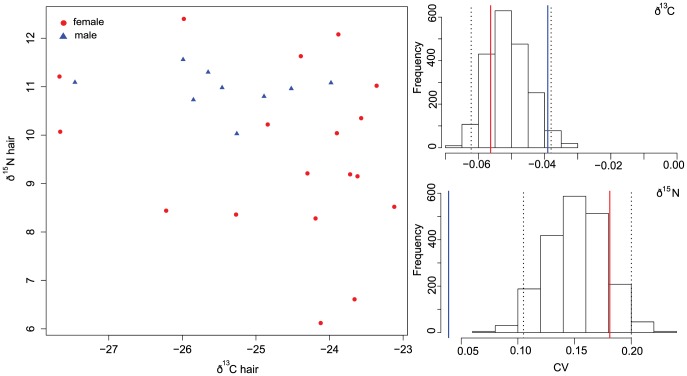
Hair stable isotope values (δ13C and δ15N) for females (red circles) and males (blue triangles).A) Values of ð13C vs. ð15N extracted from hair and B) Bootstrapped values of the coefficient of variation for both males and females combined. Vertical dashed lines denote the 95% confidence interval and solid lines show female (red) and male (blue) CV.